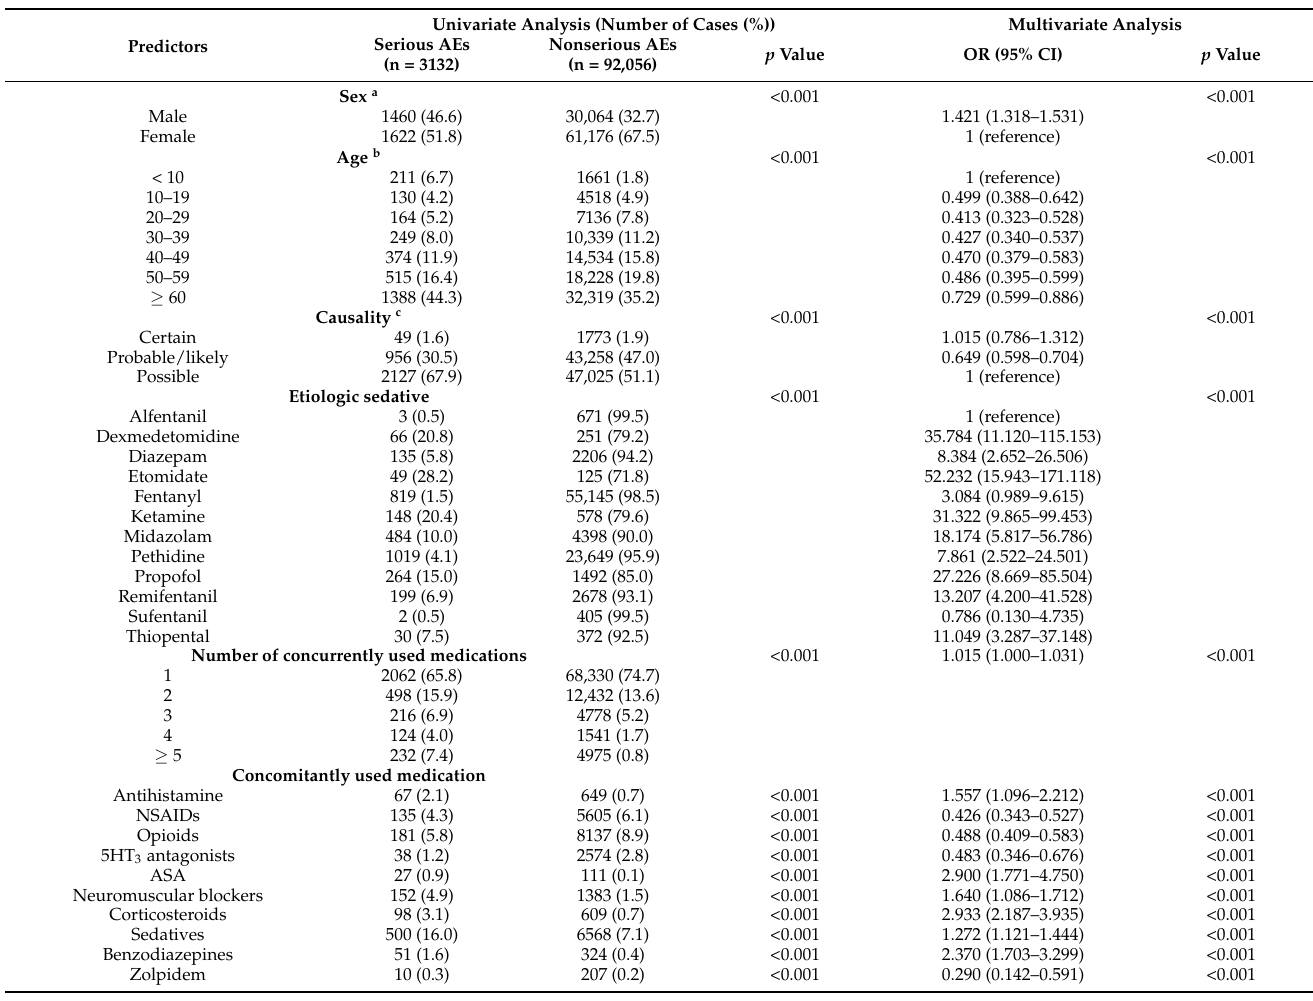
Table 4. Univariate and multivariate analyses for the association between predictors and sedative-induced serious adverse events